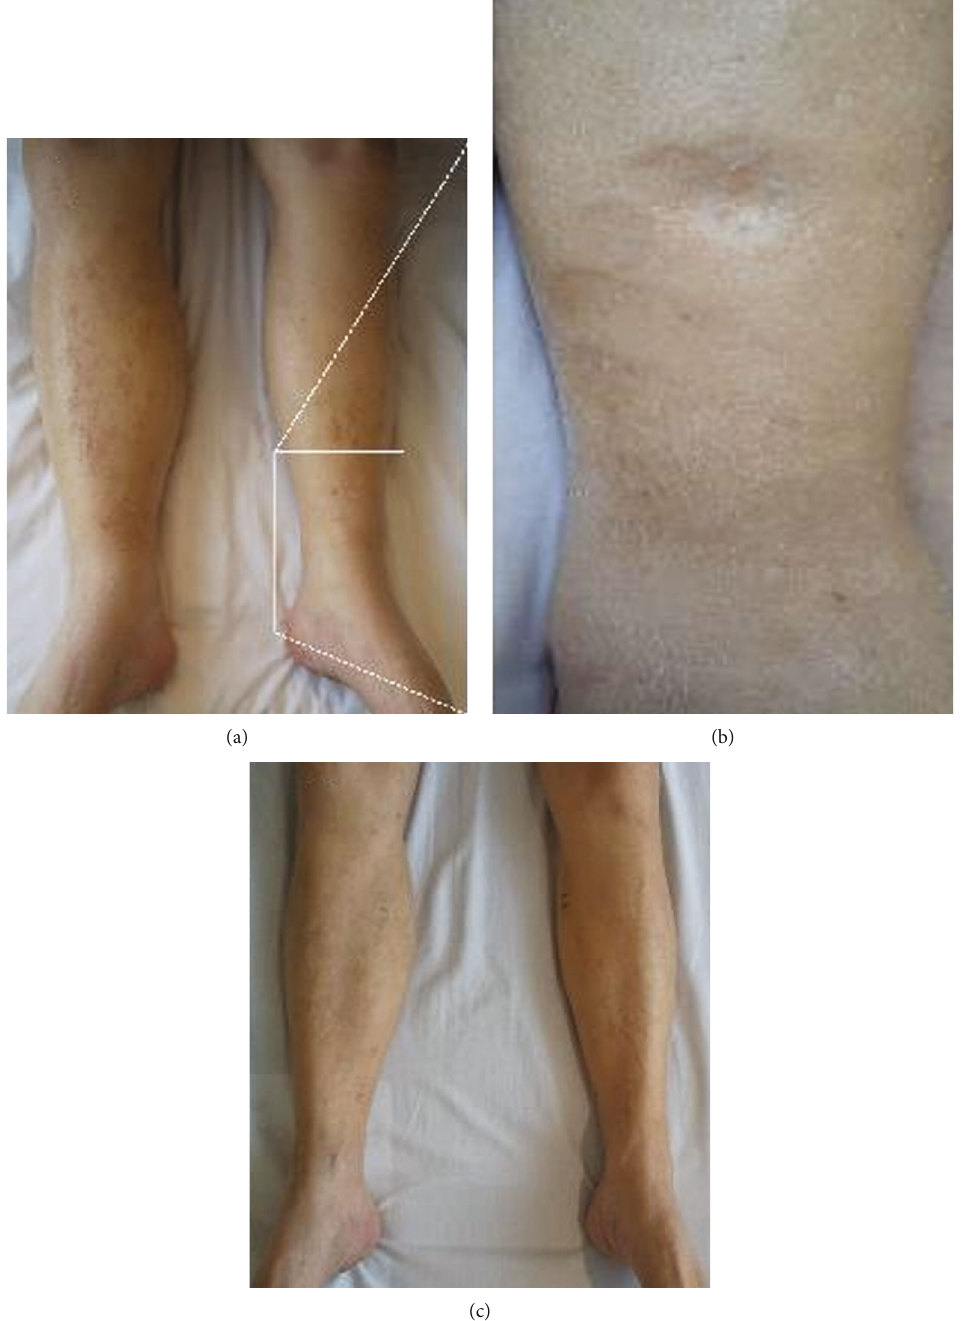
Figure 1: Photographs of the lower extremities. (a) Severe edema of the lower extremities. (b) Pitting edema in a magni fi ed area of (a). (c) Tolvaptan reduced edema without side e ff ects, leading to a body weight decrease of